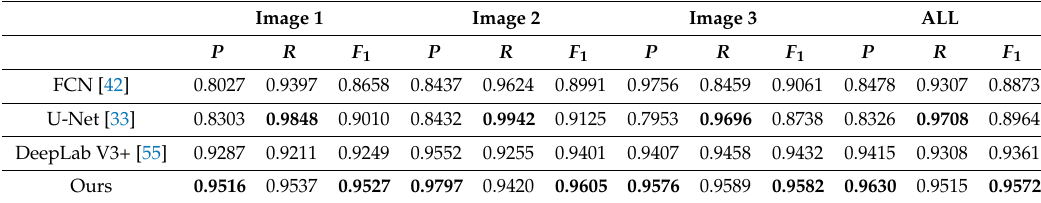
Table 2. Comparison of the results of the proposed method with other methods, where the values in bold are the best.